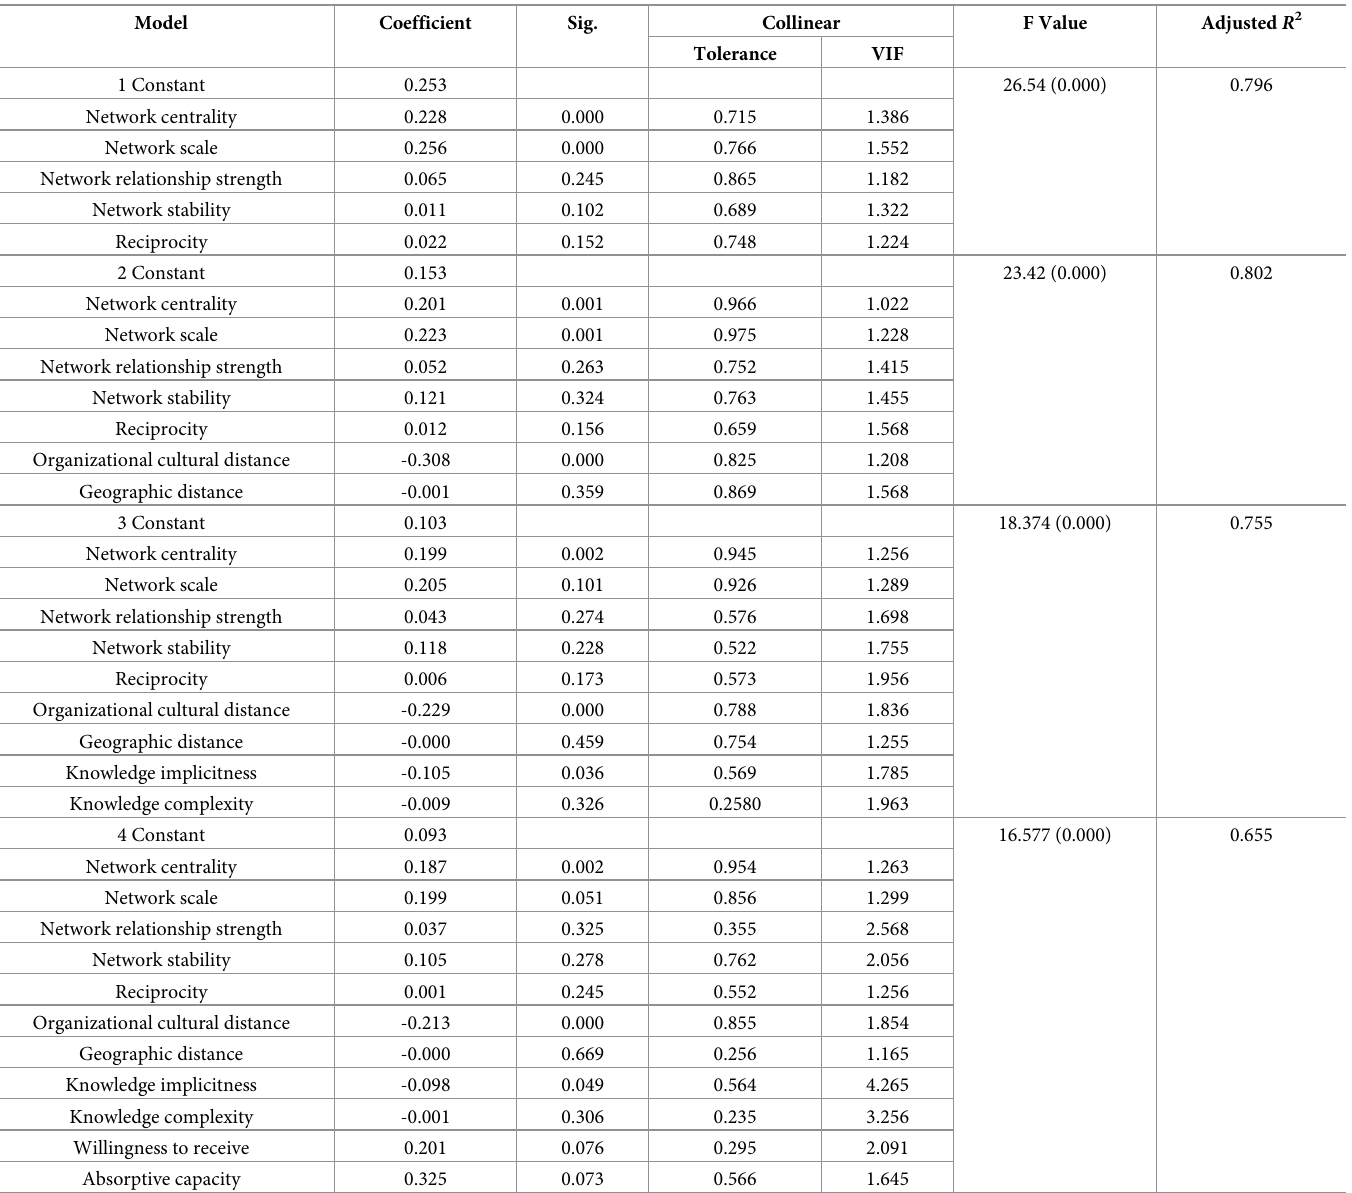
Table 17. Stepwise regression analysis results of the knowledge transfer performance impact